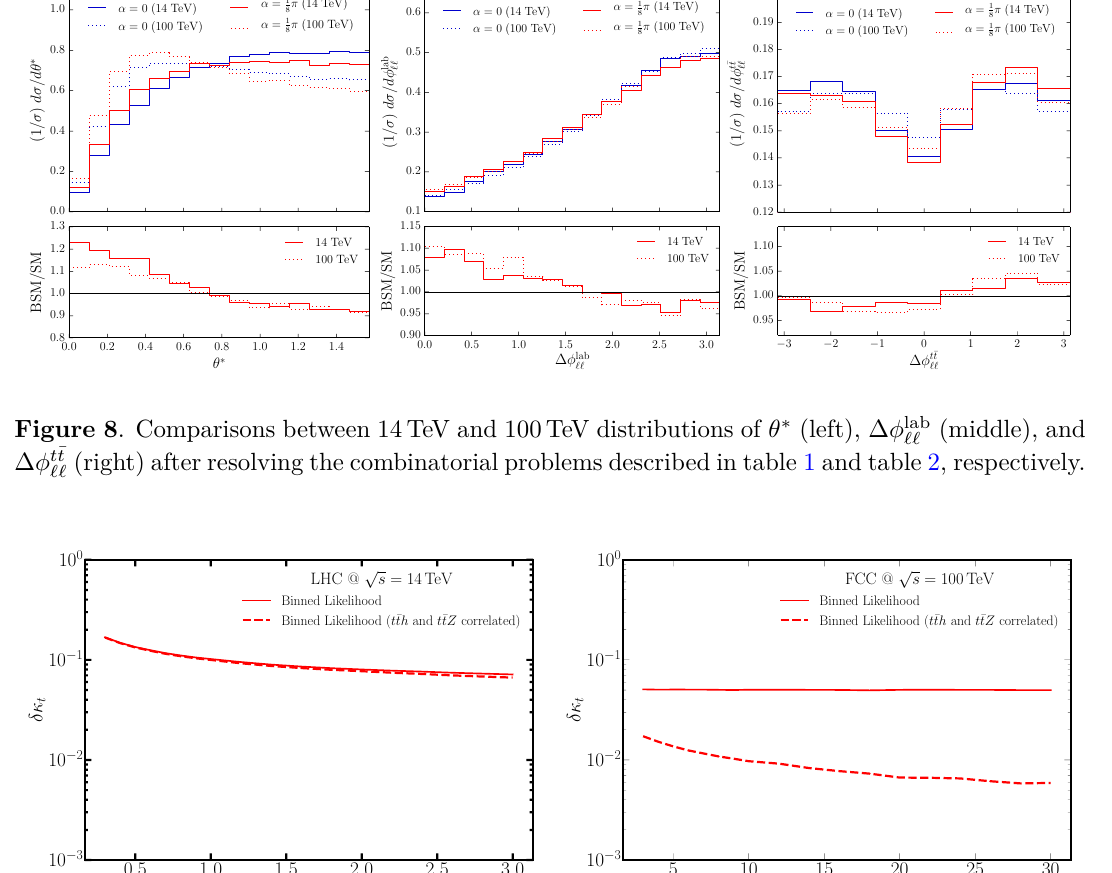
Figure 9 . The precision on κ t assuming α = 0 at using binned log-likelihood method. 20% systematics for t ¯ tb ¯ b and 10% systematics for t ¯ th and t ¯ tz are assumed. For dashed curves, the uncertainties for t ¯ th and t ¯ tz are assumed to be